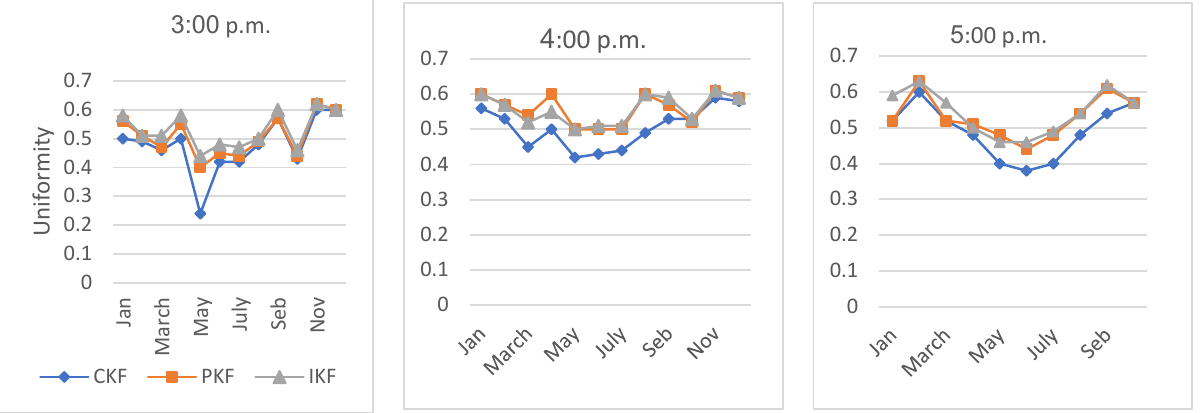
Figure 8. The uniformities and illuminance ratios (minimum illuminance value divided by maximum illuminance value) for the three proposed systems.